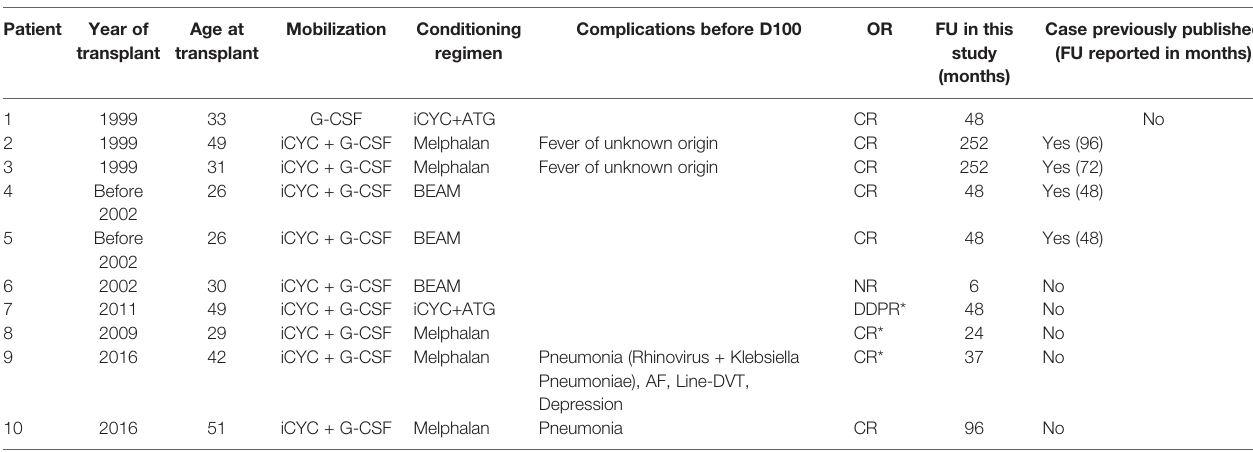
TABLE 2B | b) Characteristics of the transplantation and